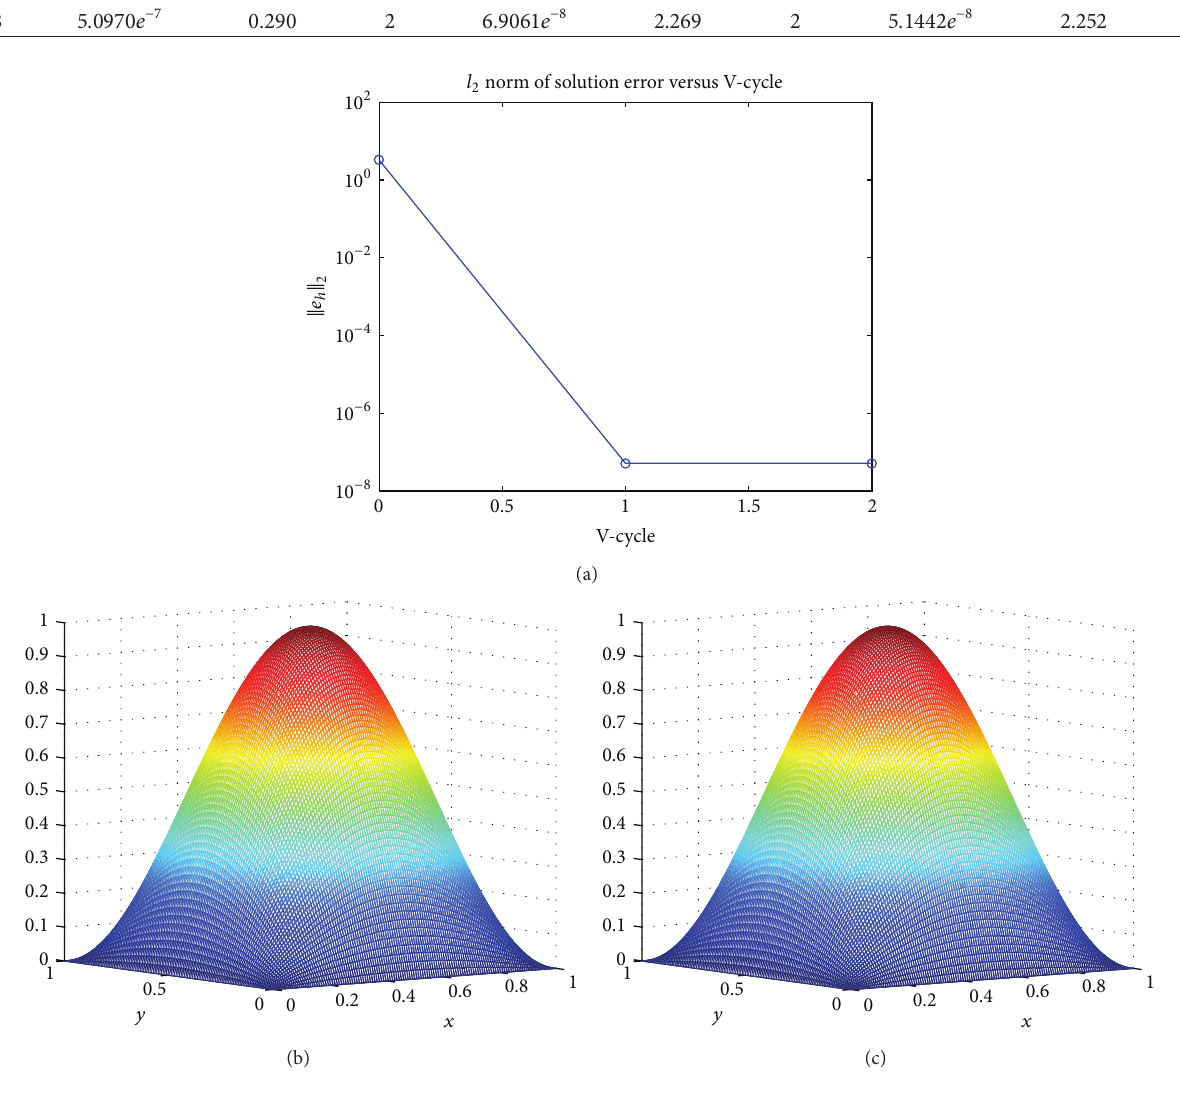
Figure 1: (a) The error graph. (b) Exact solution. (c) The approximation solution. The error vector 𝑒 𝑖𝑗 = 𝑢 𝑖𝑗 − V 𝑖𝑗 and 𝑁 = 128 are the number of nodes and ℓ = 10 for Example